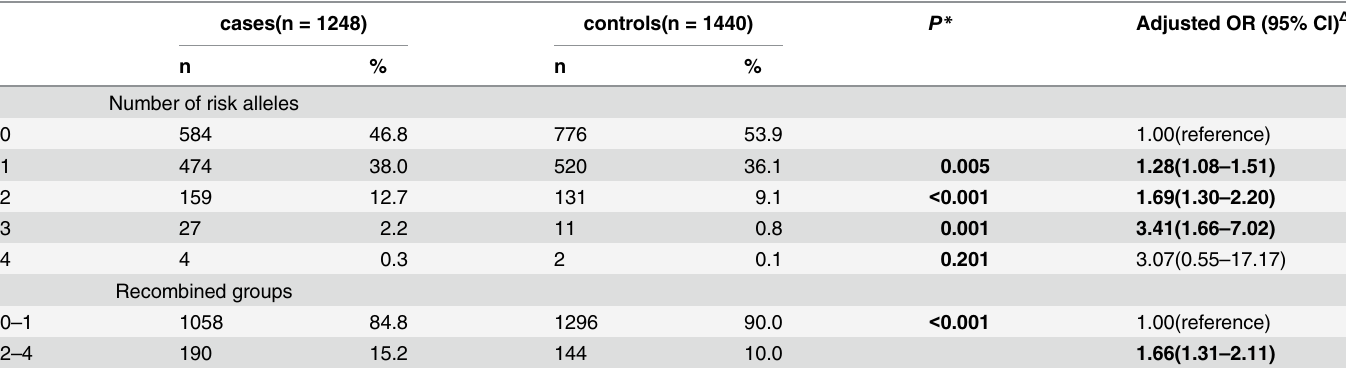
Table 4. Analysis between combined risk alleles and ccRCC